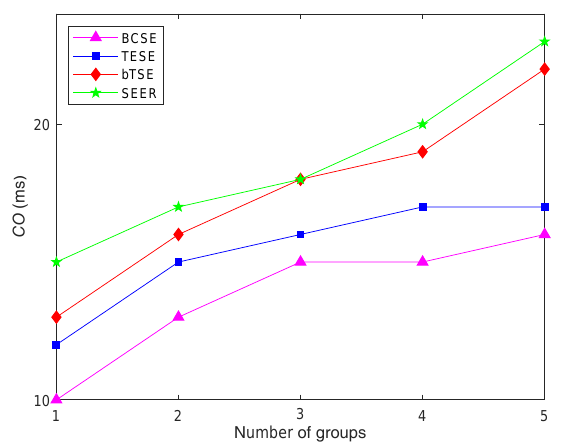
Fig. 10 Comparison of CO between the BCSE model and other